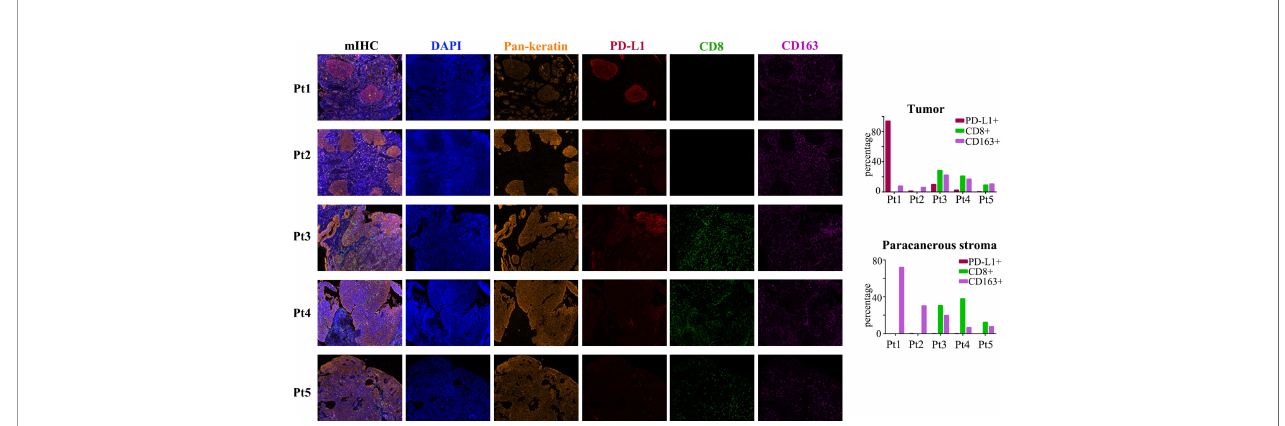
FIGURE 2 | mIHC images for the fi ve patients. Biomarkers including Pan-keratin (orange), PD-L1 (red), CD8 (green) and CD163 (purple). Expression of each PD-L1, CD8 and CD163 in the tumor and paracanerous stroma are shown in the bar